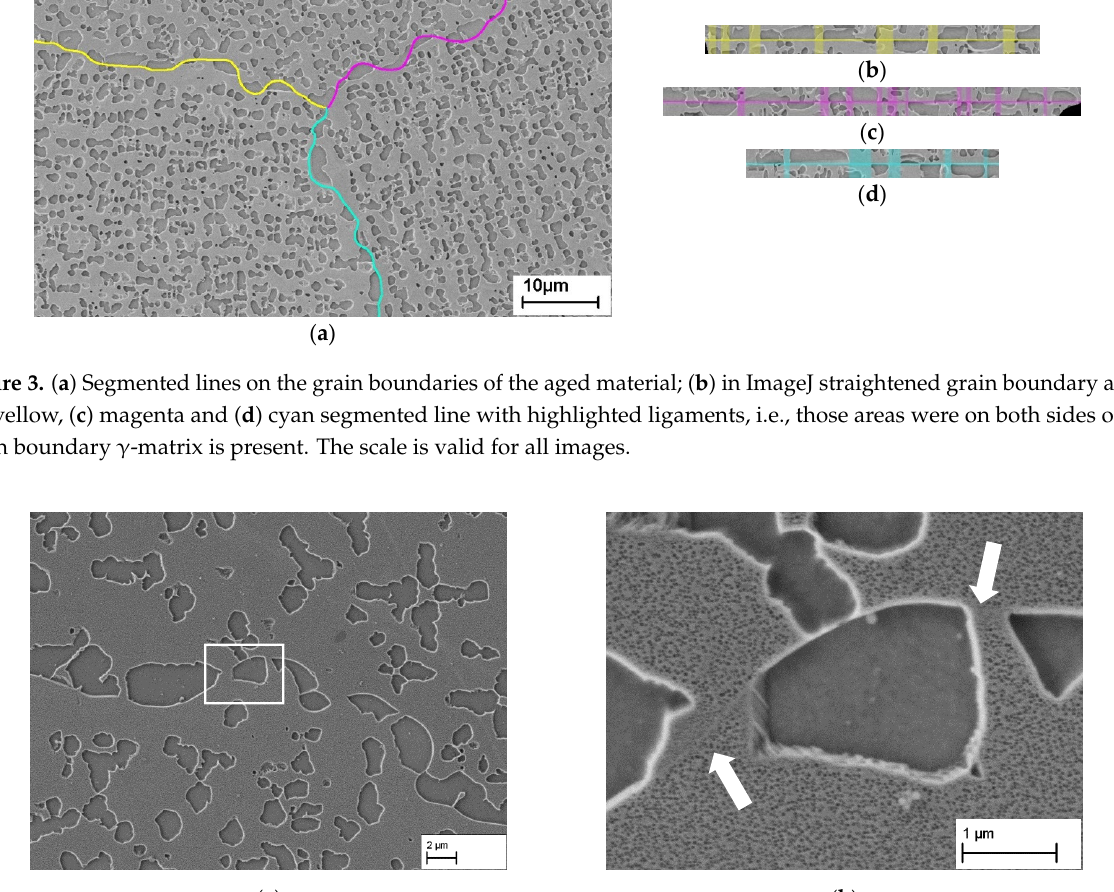
Figure 3. ( a ) Segmented lines on the grain boundaries of the aged material; ( b ) in ImageJ straightened grain boundary along the yellow, ( c ) magenta and ( d ) cyan segmented line with highlighted ligaments, i.e., those areas were on both sides of the grain boundary γ -matrix is present. The scale is valid for all images.